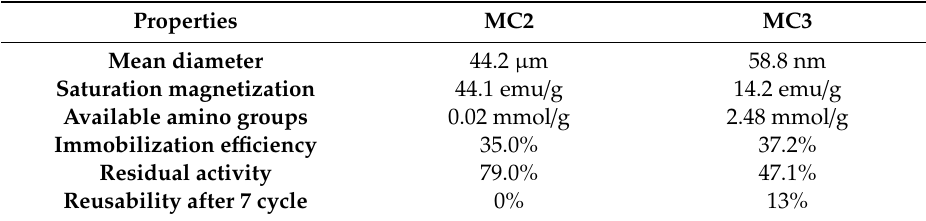
Table 2. Characterization properties comparison of chitosan functionalized metal oxide